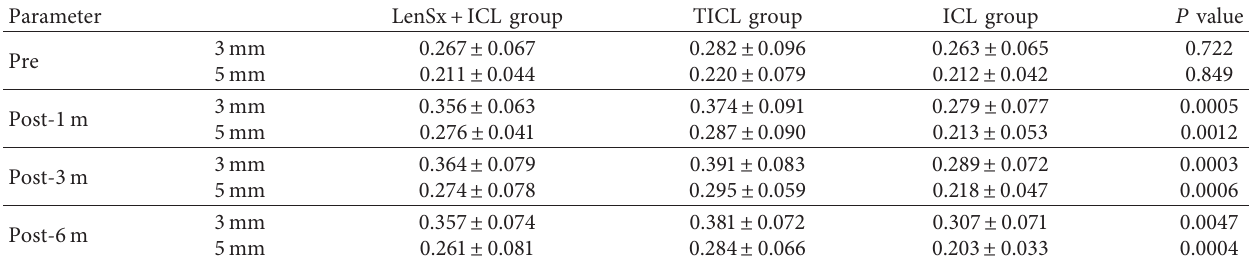
Table 5: The MTF value among three groups.